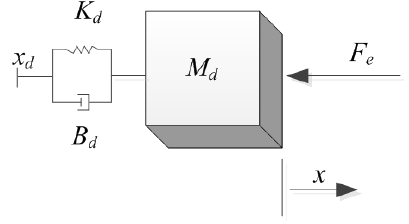
Figure 2. The dynamics of the impedance